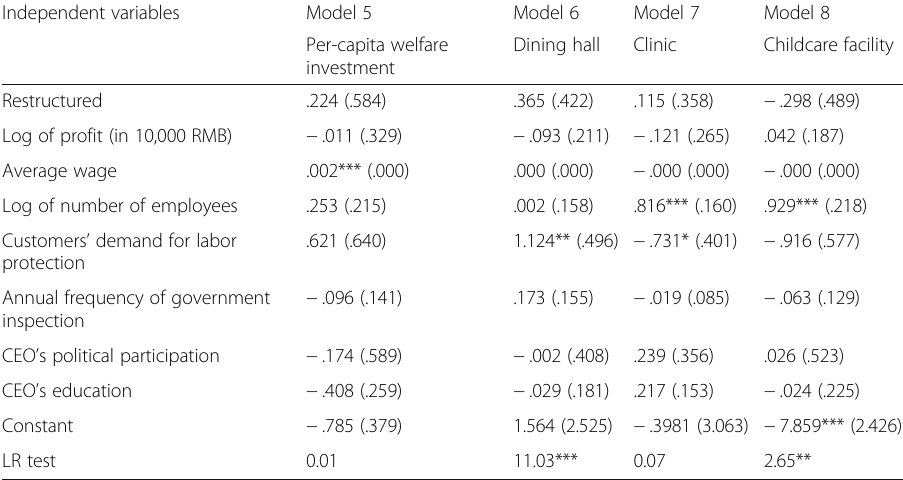
Table 3 Influence of restructuring on organizational welfare